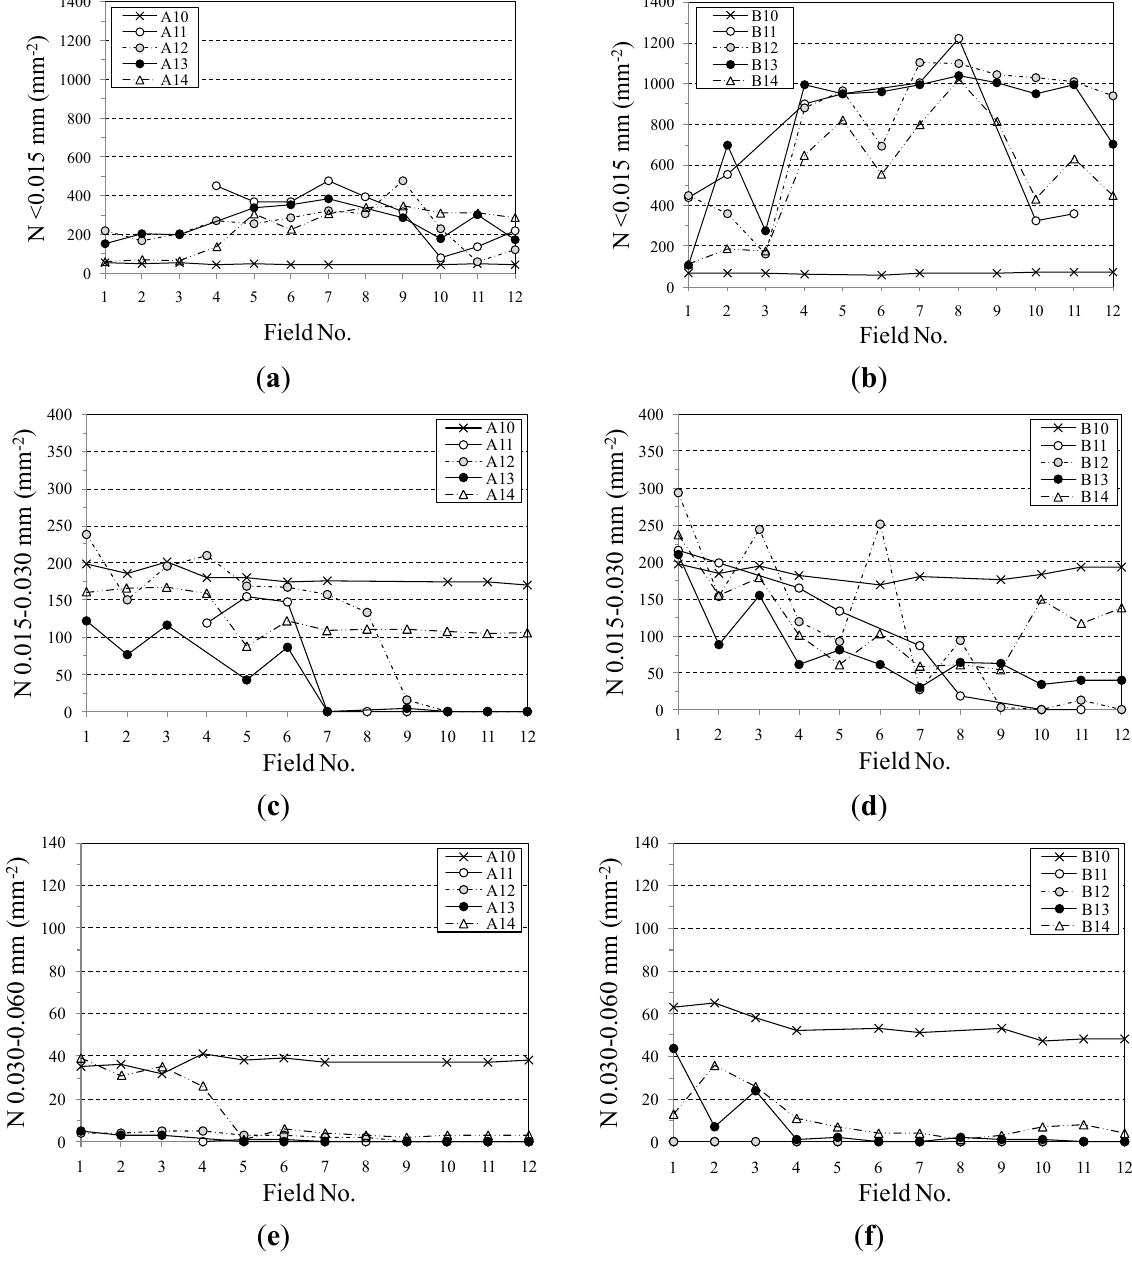
Figure 9. Nodule count distribution in all fields for the inoculated samples. ( a ) Nodule count for the smallest nodule size (<0.015 mm) of A1 series; ( b ) Nodule count for the smallest nodule size (<0.015 mm) of B1 series; ( c ) Nodule count for the nodule size 0.015–0.030 mm of A1 series; ( d ) Nodule count for the nodule size 0.015–0.030 mm of B1 series; ( e ) Nodule count for the nodule size 0.030–0.060 mm of A1 series; ( f ) Nodule count for the nodule size 0.030–0.060 mm of B1